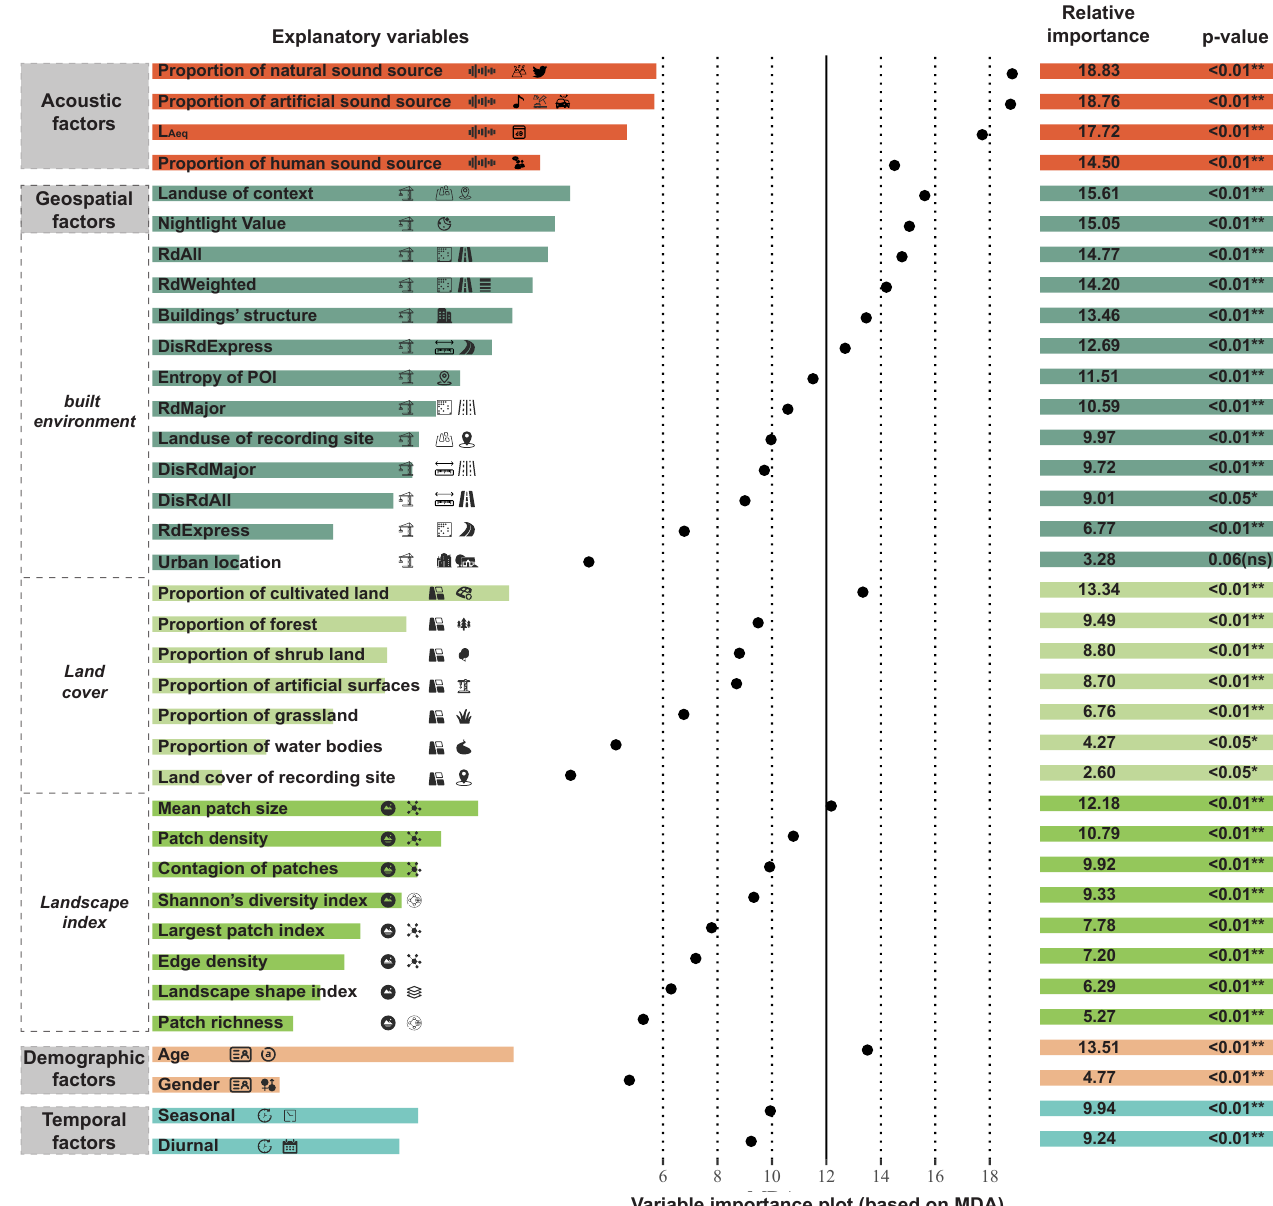
Figure 2. The relative importance and their corresponding significance of the explanatory variables